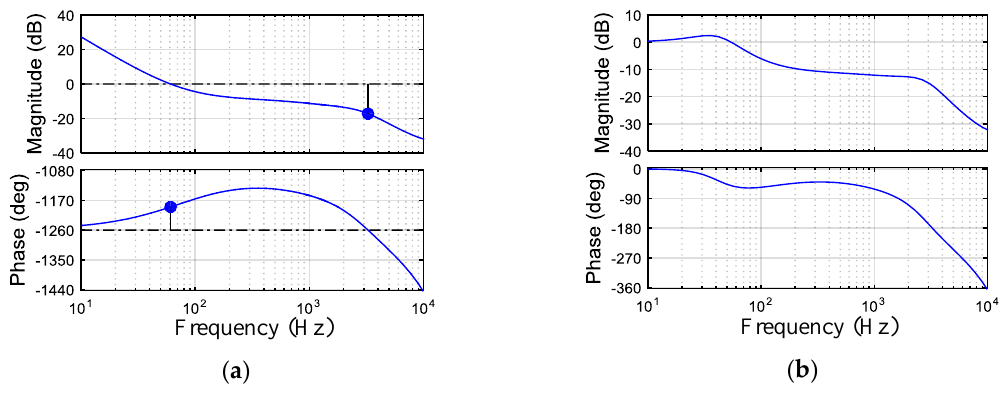
Figure 20. Frequency characteristics of the voltage loop with discrete control: ( a ) Open-loop Bode diagrams; ( b ) Close-loop Bode diagrams.